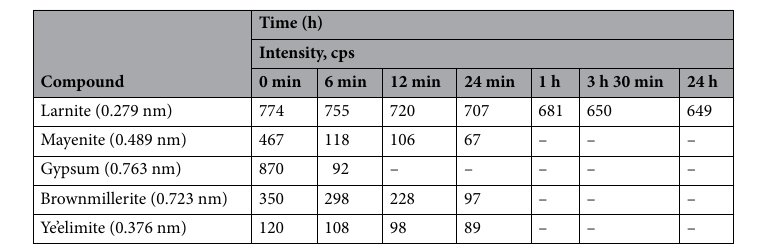
Table 4. Changes of the main diffraction peaks characteristic to the synthesis products of S2-1100 sample.